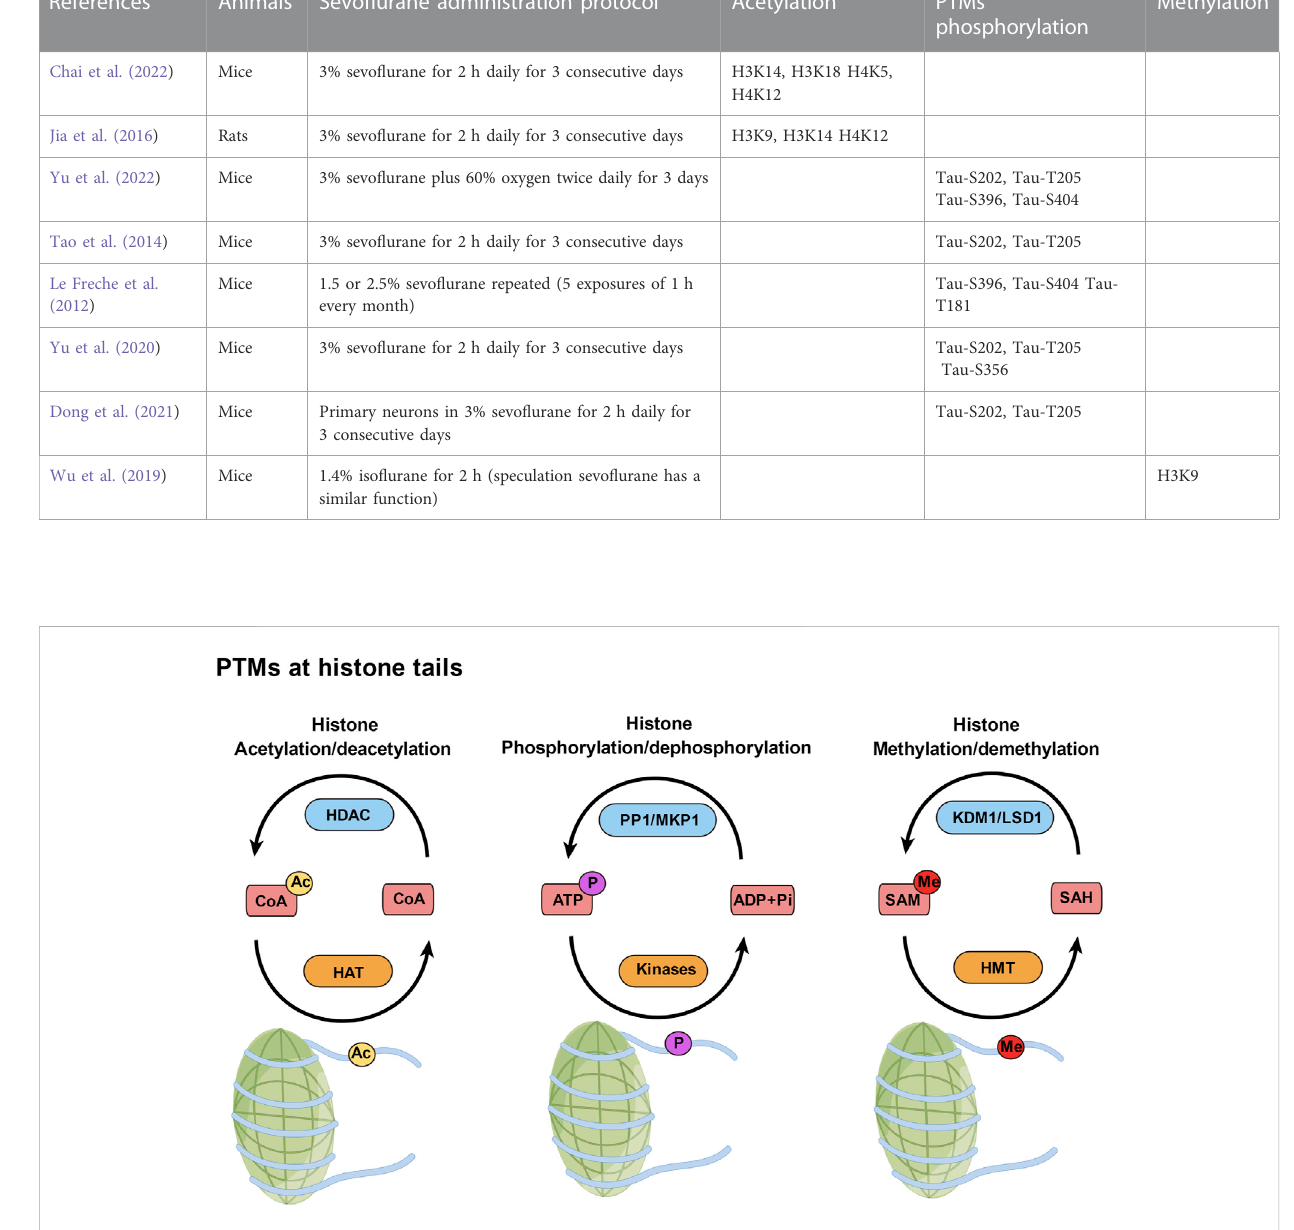
FIGURE 1 Posttranslational modi fi cations (PTMs) at histone tails. PTMs of histones, such as acetylation, phosphorylation, and methylation, are added to those amino acids by writer enzymes (orange) and removed by eraser enzymes (blue). Ac, acetyl; P, phosphate; Me,